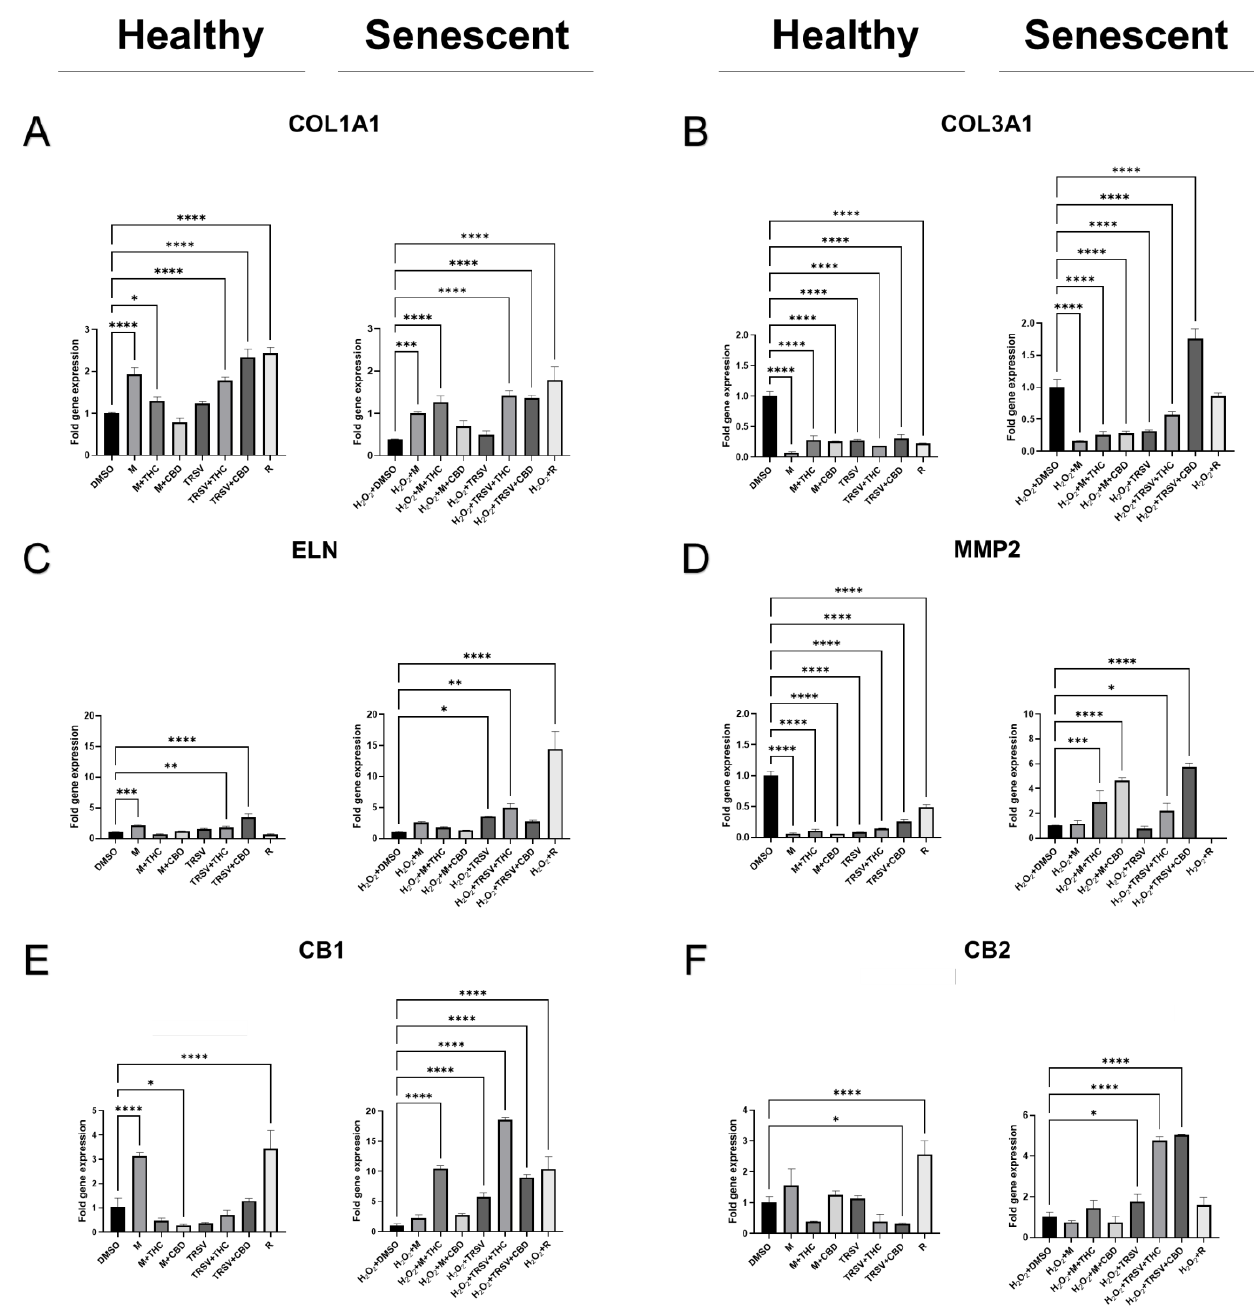
Figure 7 . Effects of phytocannabinoids and nutrient signaling regulators on the expression of genes involved in the production of extracellular matrix in CCD-1064Sk (p.11). Changes of mRNA expression as measured by RT-qPCR for ( A ) COL1A1 ; ( B ) COL3A1 , ( C ) ELN (elastin), ( D ) MMP2 , ( E ) CB1 , and ( F ) CB2 in healthy and senescent fibroblasts. Data were analyzed with a one-way ANOVA test followed by a Dunnett post hoc multiple comparison test. Bars represent mean ± SD. Significance is indicated within the figures using the following scale: * p < 0.05, ** p < 0.01, *** p < 0.001, **** p < 0.0001. CBD, cannabidiol; DMSO, dimethyl sulfoxide (vehicle), M, metformin; R, rapamycin; THC, Δ -9-tetrahydrocannabinol; TRSV, triacetylresveratrol. In healthy fibroblasts, we found metformin and rapamycin increased expression of CB1 , while metformin + CBD significantly inhibited CB1 expression in healthy dermal fi- broblasts (Figure 7E). Similarly, metformin and TRSV appeared to decrease CB1